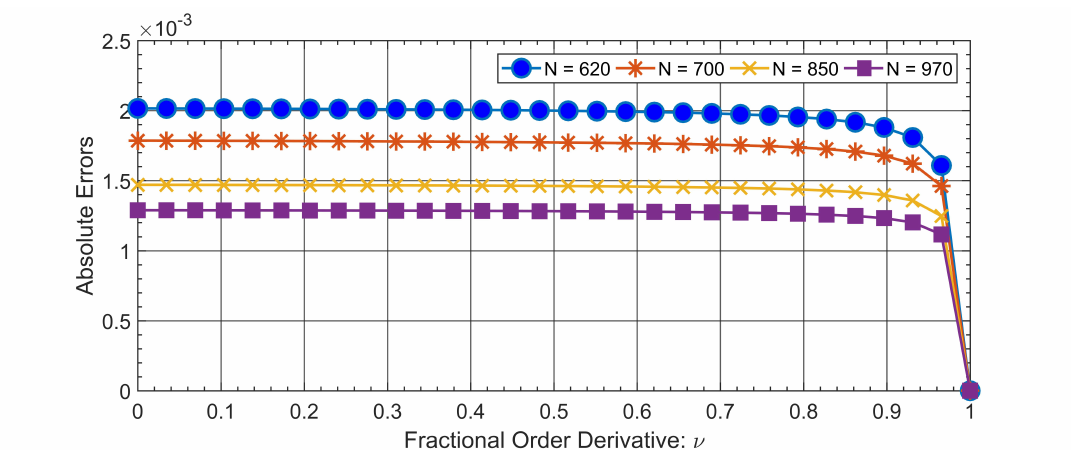
Figure 1. Absolute errors vs. fractional order ν for the approximation of continuous uniform mesh for a temporal variable using the Caputo-Fabrizio operator on a given function f ( t ) = t 2 with a varying number of mesh points.